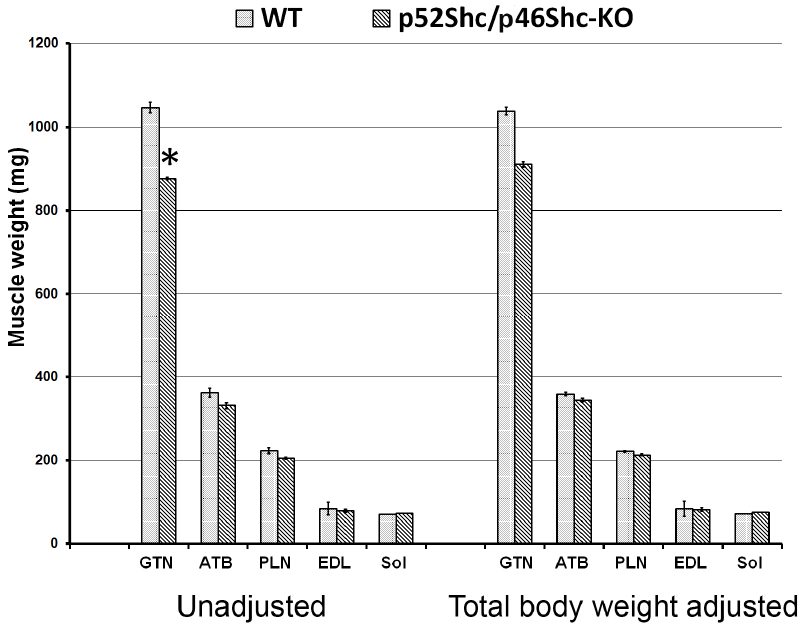
Figure 3. Skeletal muscle mass of p52Shc/p46Shc-KO rats and WT littermates. Absolute unad- justed and total body weight adjusted weight of GTN, PLN, EDL, and Sol muscles is presented. *: indicates a significant difference from the WT definition.